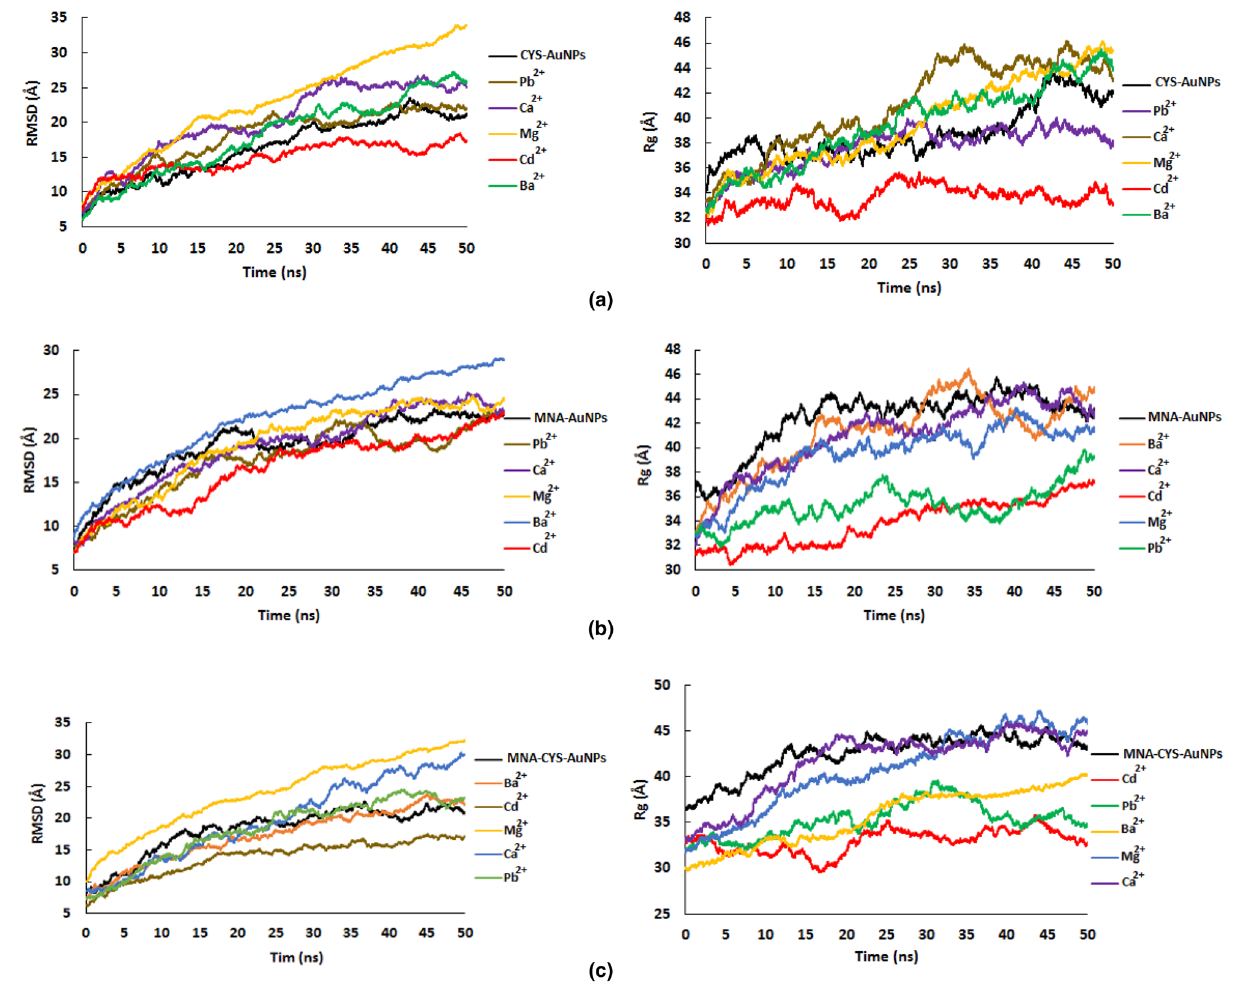
Figure 5. The calculated RMSD and Rg values of CYS-AuNPs ( a ), MNA-AuNPs ( b ), and MNA-CYS-AuNPs ( c ) in the presence of different metal